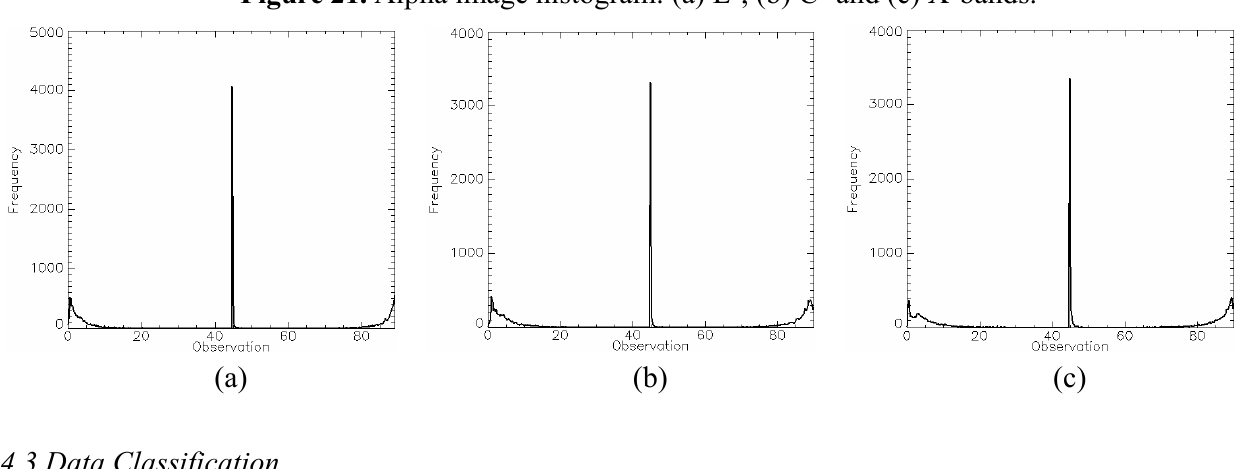
Figure 21. Alpha image histogram: (a) L-, (b) C- and (c)